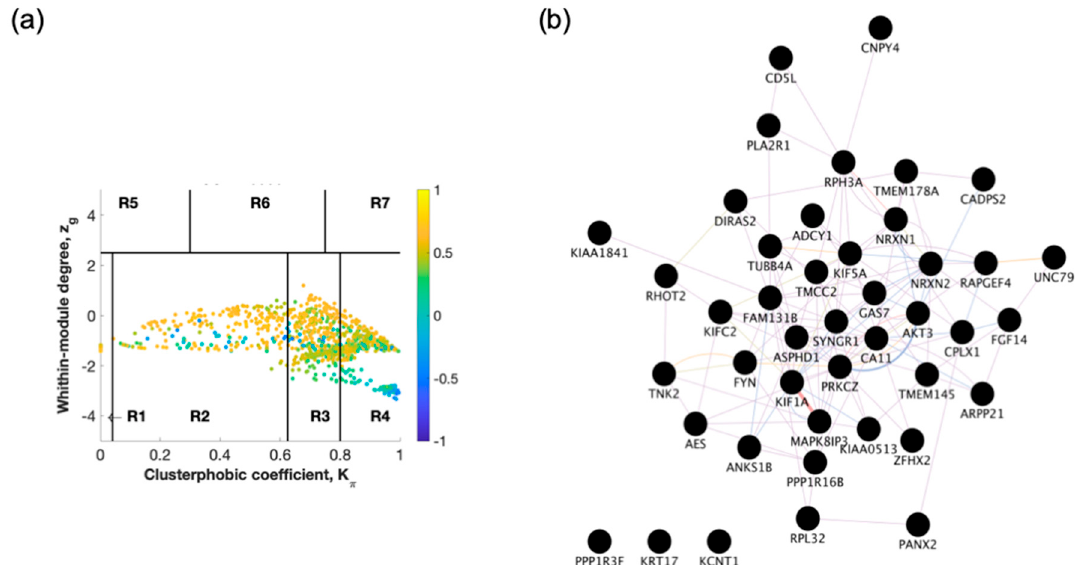
Figure 3. Identification of AD versus asymptomatic AD (AsymAD) switch genes. ( a ) Heat cartography maps of nodes of the AD/AsymAD correlation networks from the GSE118553 dataset as previously mentioned. ( b ) Network analysis. Gene network analysis was performed using GeneMANIA in Cytoscape v3.8.0. Input genes are shown in black circles. Purple, blue, and pink lines represent co-expression, co-localization, and physical interactions, respectively. SWIM analysis identified 72 switch genes comparing AD and healthy individuals, including 59 protein-coding genes, 2 non-coding RNAs (HAR1A and RNU4ATAC), and 11 chromosomal loci (Table S1). Fifty-one switch genes were discovered comparing AD